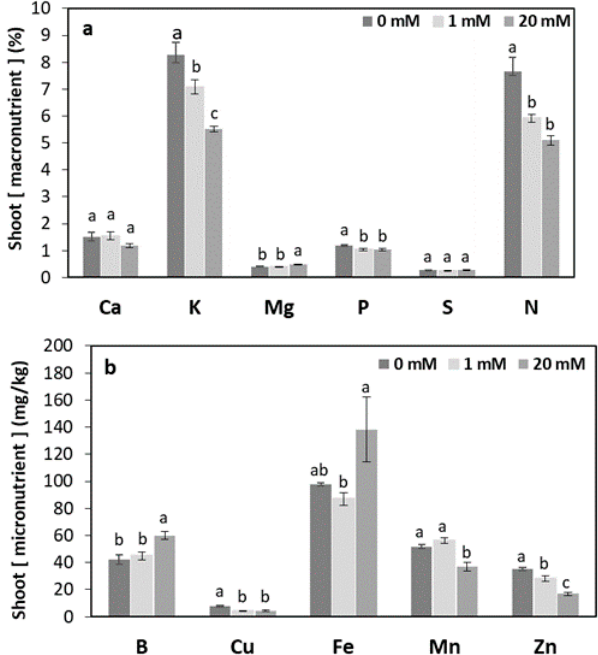
Figure 1. Bicarbonate effects on lettuce shoot macronutrient ( a ): calcium (Ca), potassium (K), magnesium (Mg), phosphorus (P) and nitrogen (N), and micronutrient ( b ) concentrations: boron (B), copper (Cu), iron (Fe), manganese (Mn) and zinc (Zn). Experiment 3. Values with different letters indicate statistically significant differences according to one-way ANOVA test ( p < 0.05), followed by LSD post-hoc analysis. Bars represent the means ± SE ( n = 4). Table 4. Total nutrient content of lettuce plants exposed to 0, 1 and 20 mM HCO 3- . Experiment 3. Values are means ± S.E. of 4 replicates, with different letters within a column denoting significant differences between means (post-hoc LSD p < 0.05).